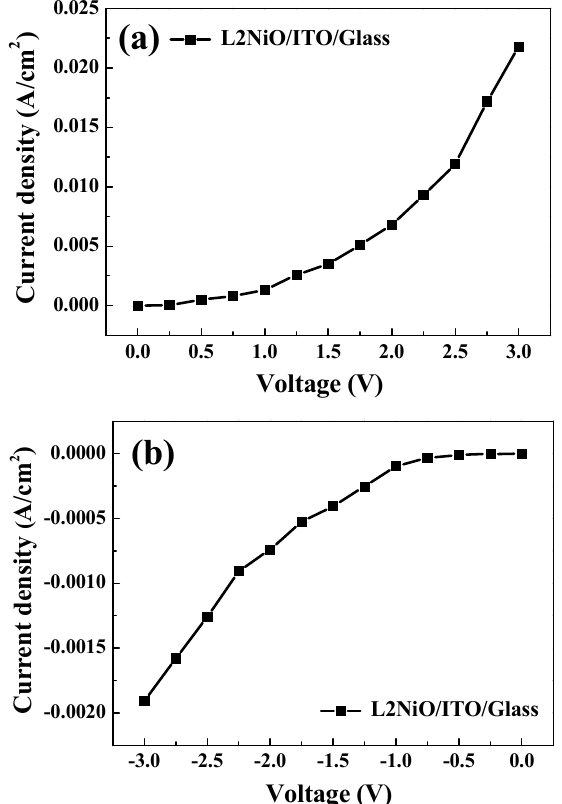
Figure 10. Current–voltage curve of the L2NiO / ITO transparent heterojunction diode: ( a ) forward current and ( b ) reverse current.